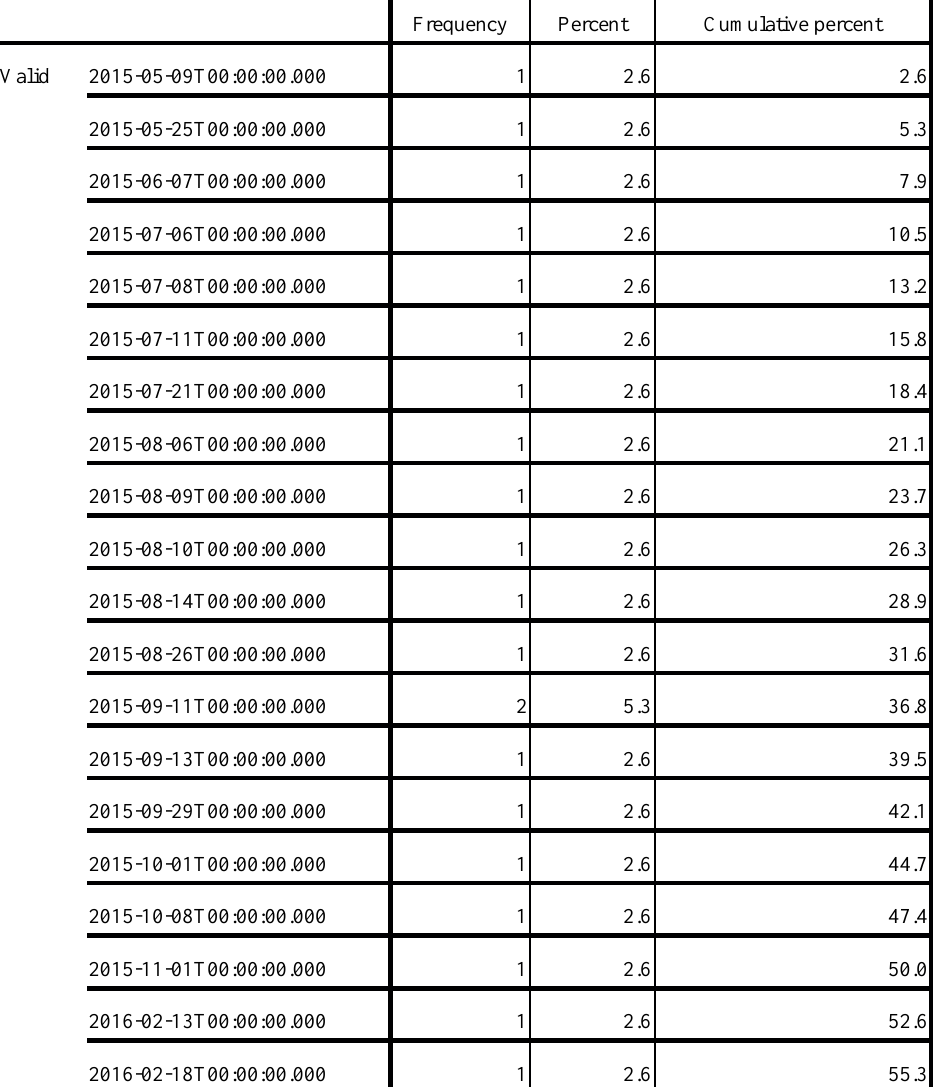
Frequency of Questions Asked With Either Climate/Weather, Drought, or Irrigation Keywords Frequency Percent Cumulative